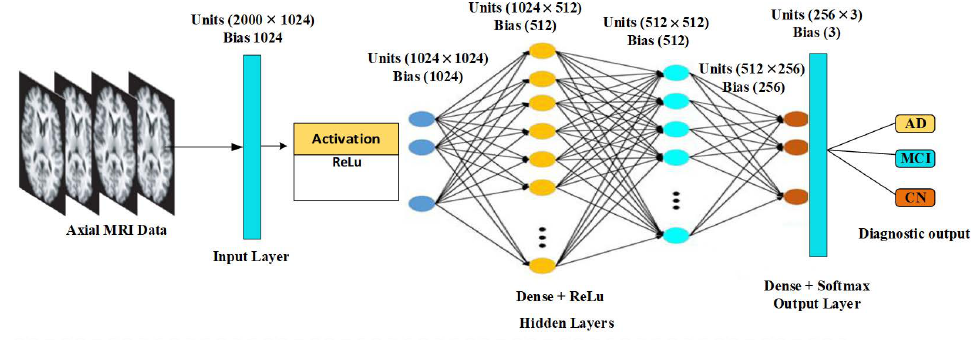
Figure 6. Layers and parameters used in multilayer perceptrons neural network (MLP-NN) archi-